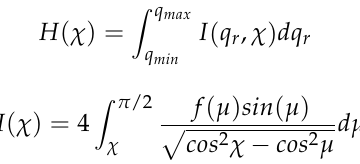
→ K 0 is a wave vector of the incident beam, (cid:4652)(cid:4652)(cid:4652)(cid:4652)(cid:4652)⃗ → → is a wave vector of the incident beam, 𝐾 (cid:2869) → q = K 1 − K 0 —scattering vector. ( B ) The angle of an individual fibril (cid:4652)(cid:4652)(cid:4652)(cid:4652)⃗ − 𝐾 (cid:4652)(cid:4652)(cid:4652)(cid:4652)⃗ —scattering vector. ( B ) The angle of an individ- (cid:2868)